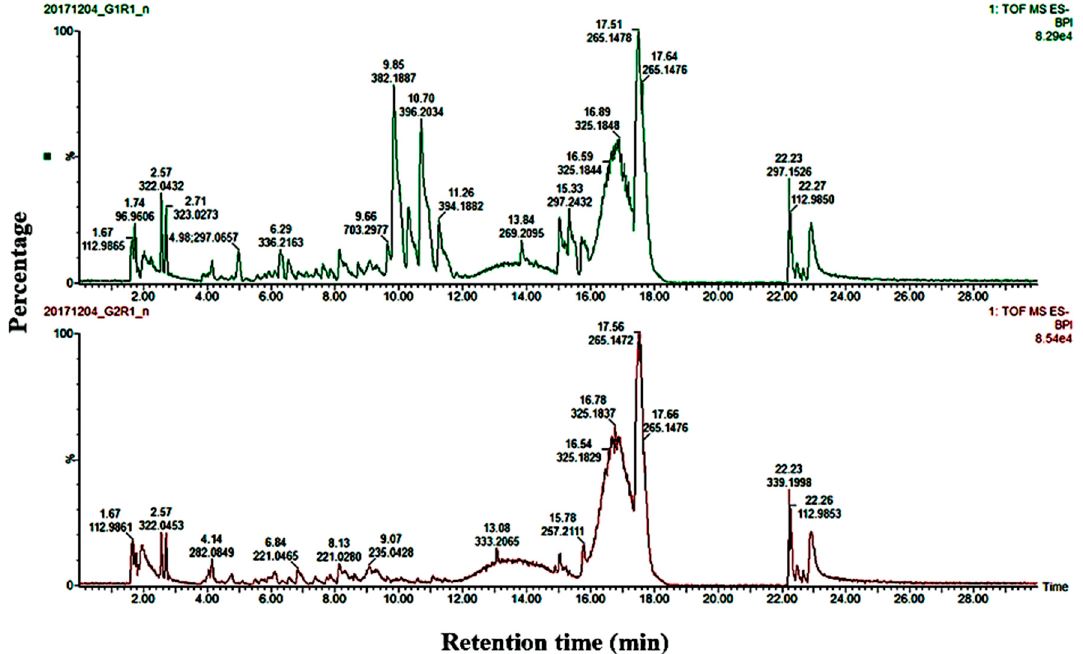
Figure 1. Base peak chromatogram spectra of potato root exudates collected from a tolerant potato cultivar Innovator. Represented: inoculated (G1R1; top graph) and uninoculated (G2R1; bottom graph) with Spongospora subterranea f. sp. s ubterranea .